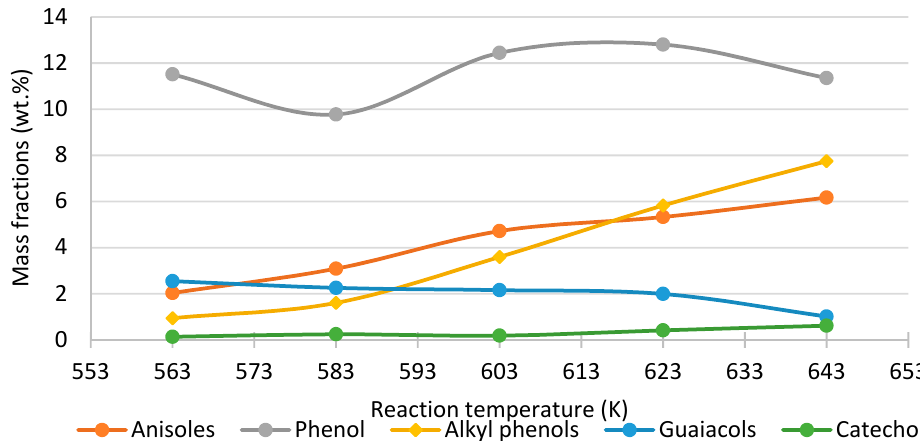
Figure 8. Effect of temperature on mass fractions of monocyclic aromatic compounds in bio-oil. Data is taken from [107]. The curves are guides to the eye.